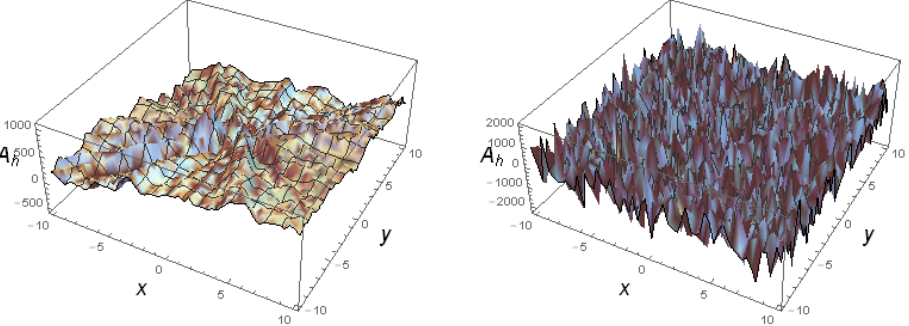
Figure 2 . Slices of two 100-dimensional random functions. We generate 100-dimensional random functions with parameters (cid:11) = 50, (cid:12) = 50, ! = 50, h = 1000 for sigmoid (left) and sine (right) activation functions respectively. We plot the function A h (0 ; 0 ; : : : ; x; y ) (The (cid:12)rst 98 components of the variable vector are all zero and the last two components are chosen to be x and y